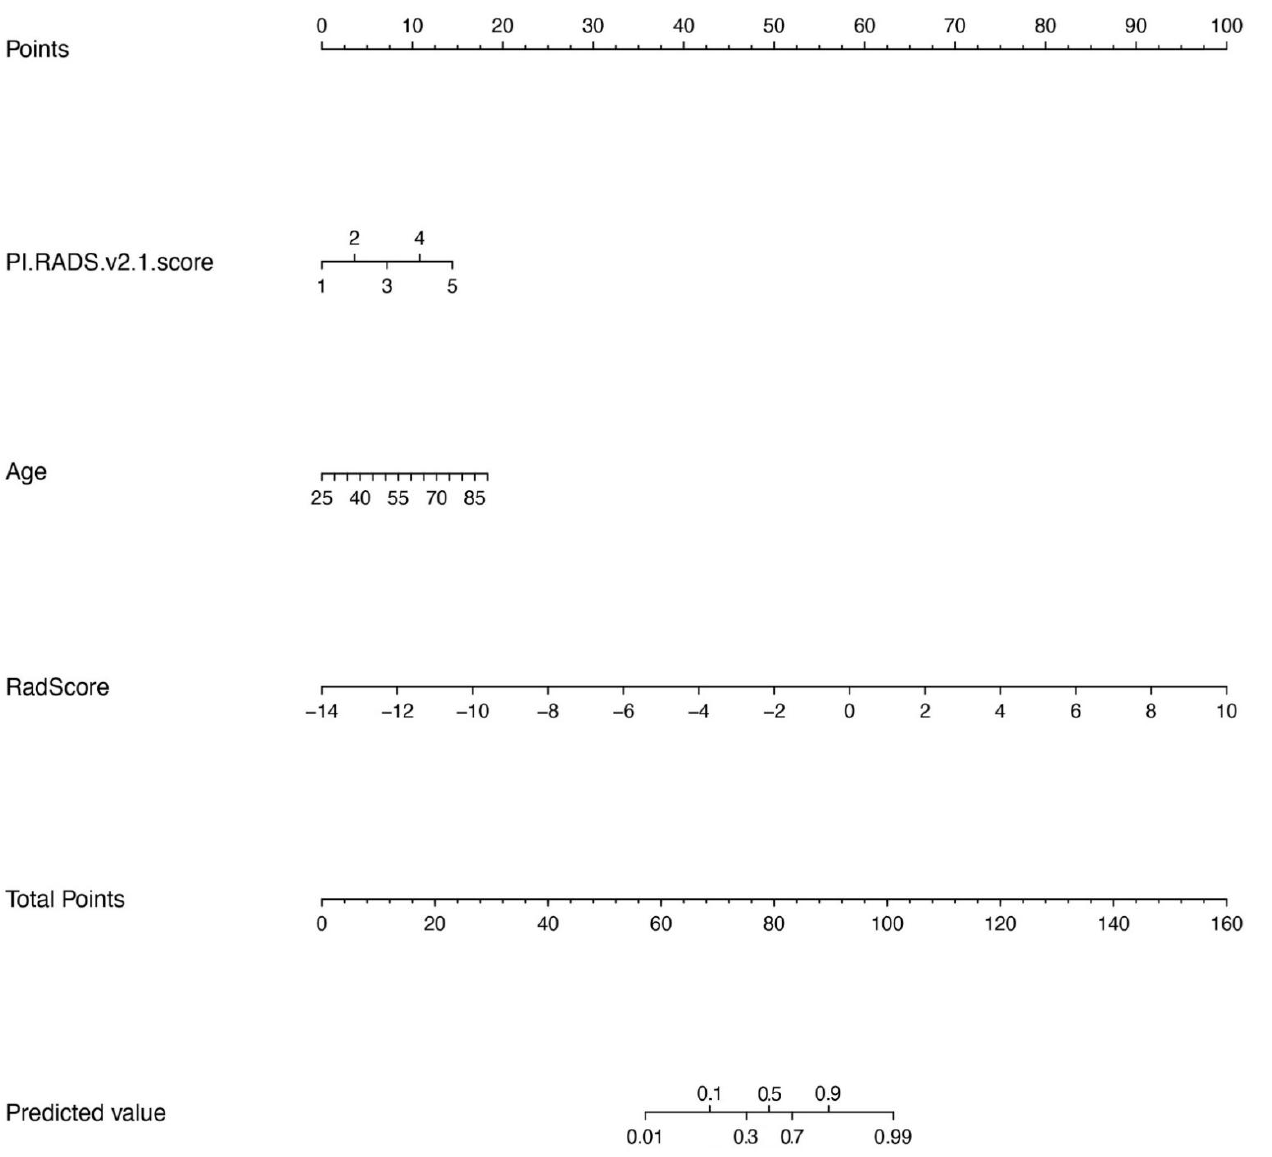
Figure 4. Nomogram with the radiomics score (Rad-score) and clinical factors incorporated.